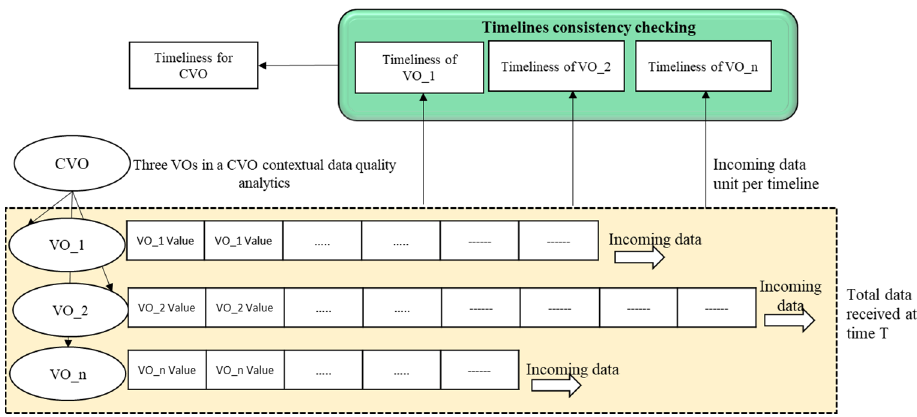
Figure 11. Timeliness metric assessment mechanism.